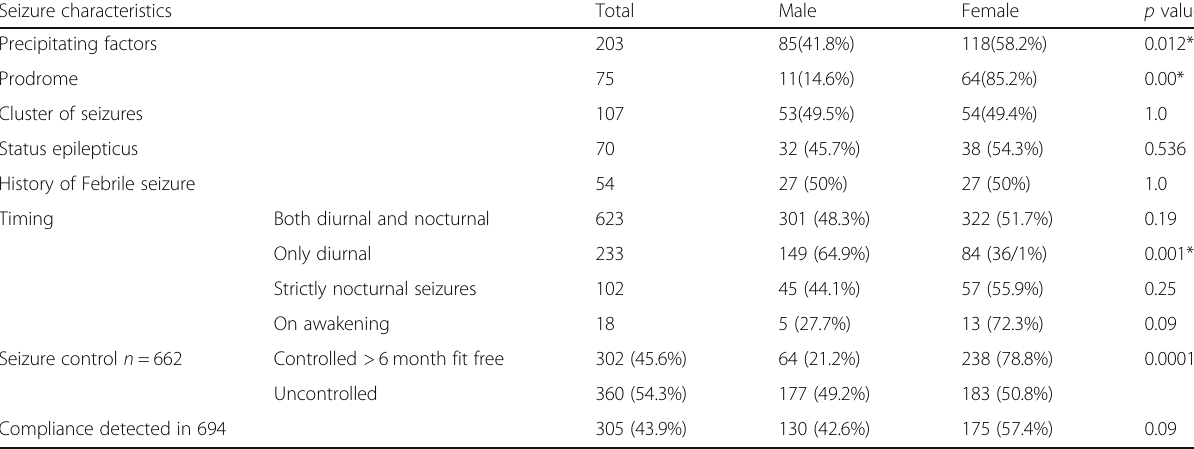
Table 3 Gender differences in different seizure